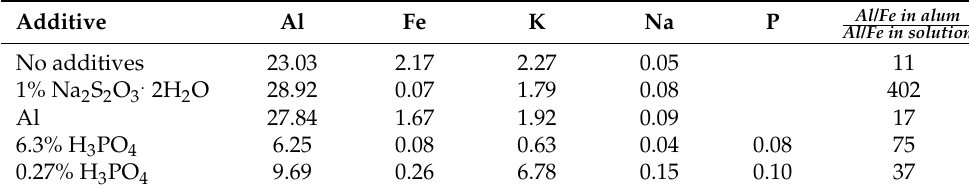
Table 5. Distribution coefficients for the components in solid and liquid phases in equilibrium. Additive Al Fe K Na No